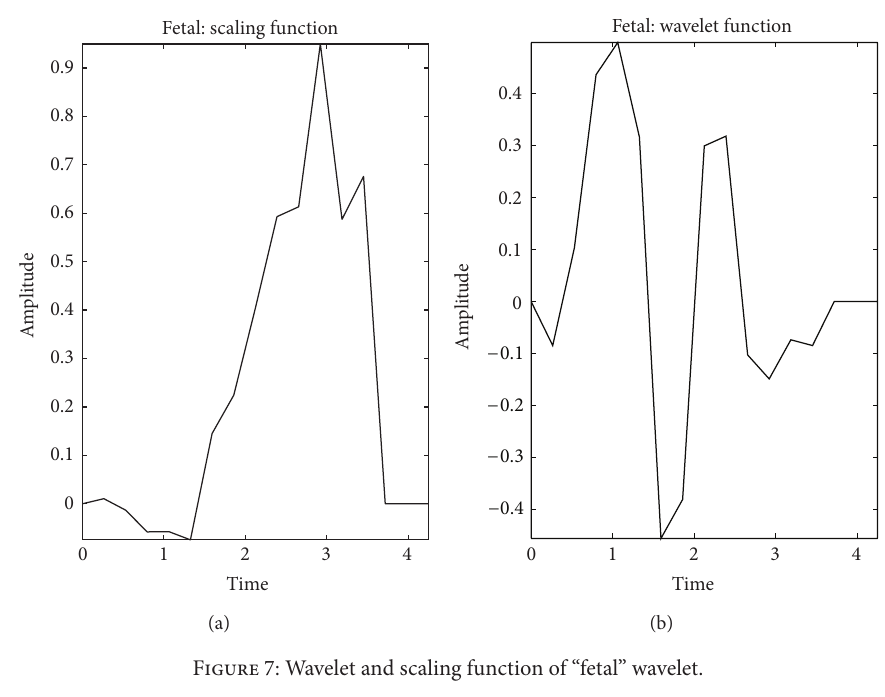
Figure 7: Wavelet and scaling function of “fetal” wavelet.